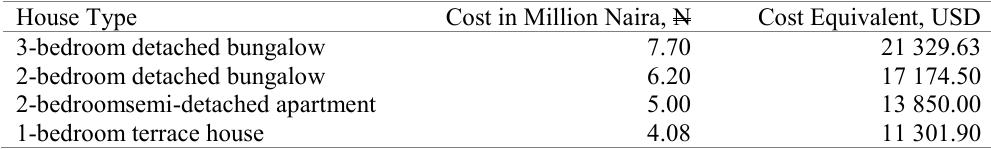
Table 5 . Cost of Newly Constructed Houses in Jos Metropolis House Type Cost in Million Naira,